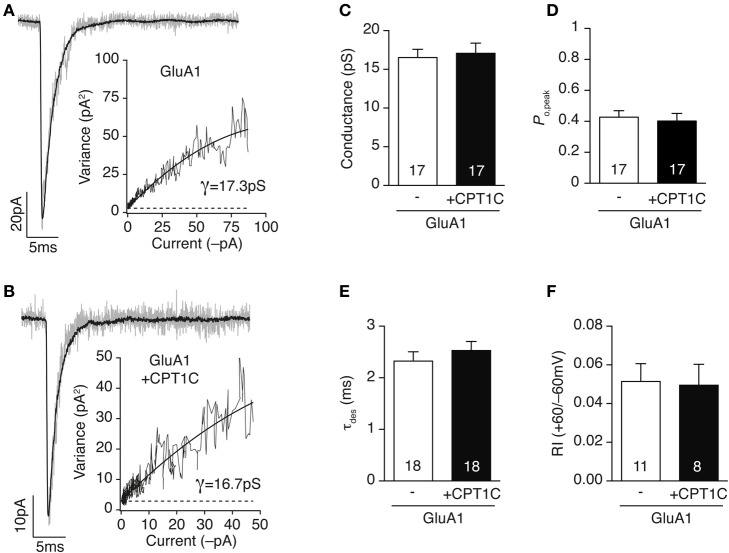
CPT1C does not alter AMPAR gating properties. (A) Current activated by rapid application of 10 mM glutamate (100 ms, −60 mV) to an outside-out patch from a tsA201 cell expressing GluA1 alone. Gray trace represents a single response and black line the average of 37 responses. Inset shows the current variance vs. mean current plot for this patch. The weighted mean single-channel conductance estimate for this record was 17.3 pS. (B) Same as (A) but for a cell expressing GluA1 plus CPT1C-GFP (CPT1C). Black line is the average of 38 responses. Inset: current variance vs. mean current plot for this patch giving a weighted mean single-channel conductance of 16.7 pS. (C–F) CPT1C has no influence on either weighted single channel conductance (C; pS), peak open probability (D; Po,peak), desensitization kinetics (E; τdes) or rectification index (F; I+60mV/I−60mV) of GluA1 homomeric AMPARs. P > 0.05, Mann–Whitney U-test for all groups. Numbers in bars denote the number of recordings.